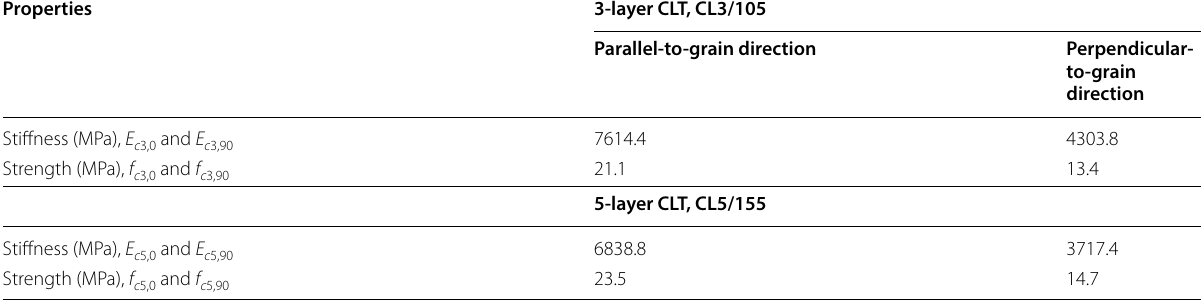
Table 5 Compressive properties of the CLT panels Properties 3-layer CLT, CL3/105